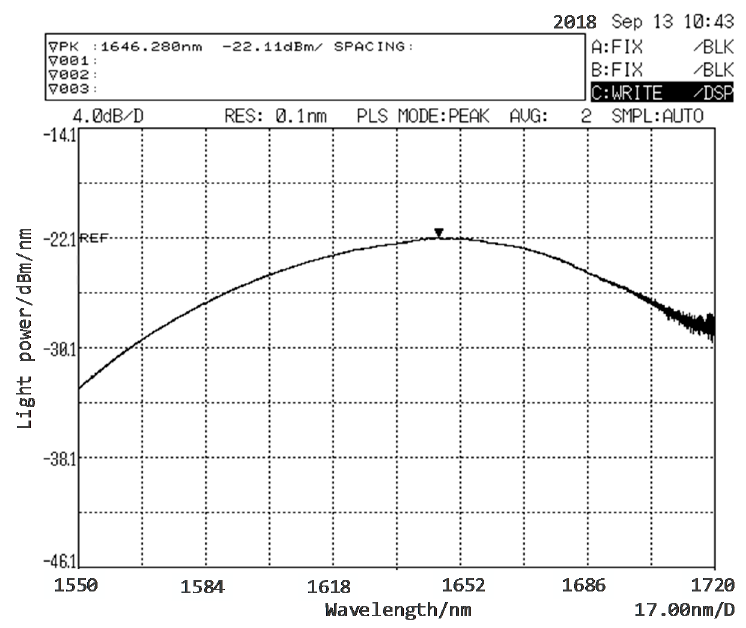
Figure 3. The power spectrum of SLED. Table 1. Methane gas test results and relative errors.